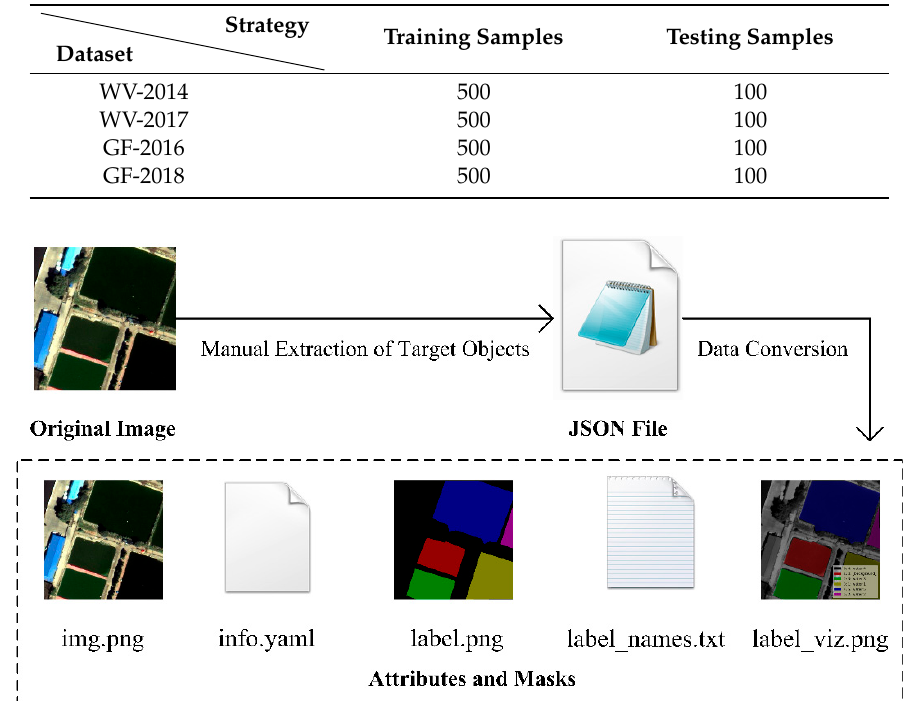
Figure 11. The technical process of water sample construction method. The original image was manually labeled to generate the label, mask and the position information of water bodies.